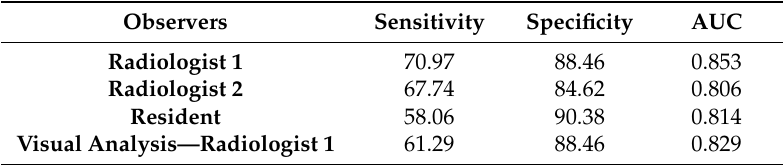
Table 3. Classification of the lesions based on the manual delimitation of radiologists.